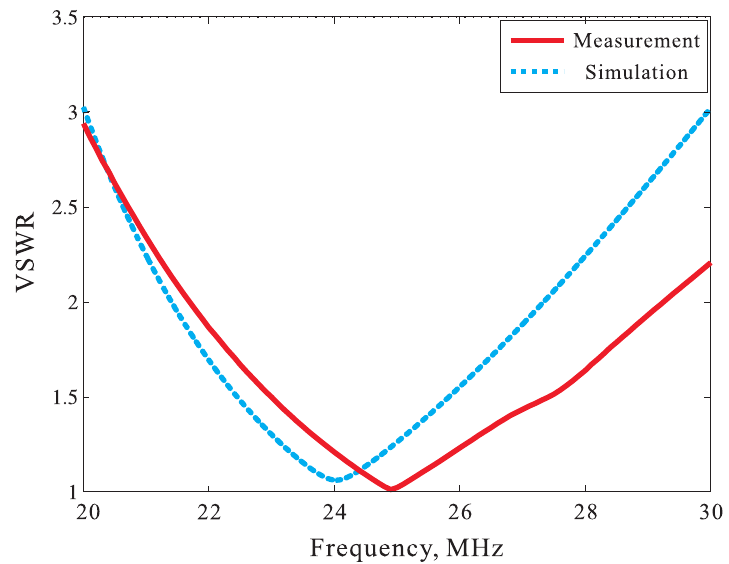
Figure 7. Simulated and measured VSWRs of the proposed antenna with the